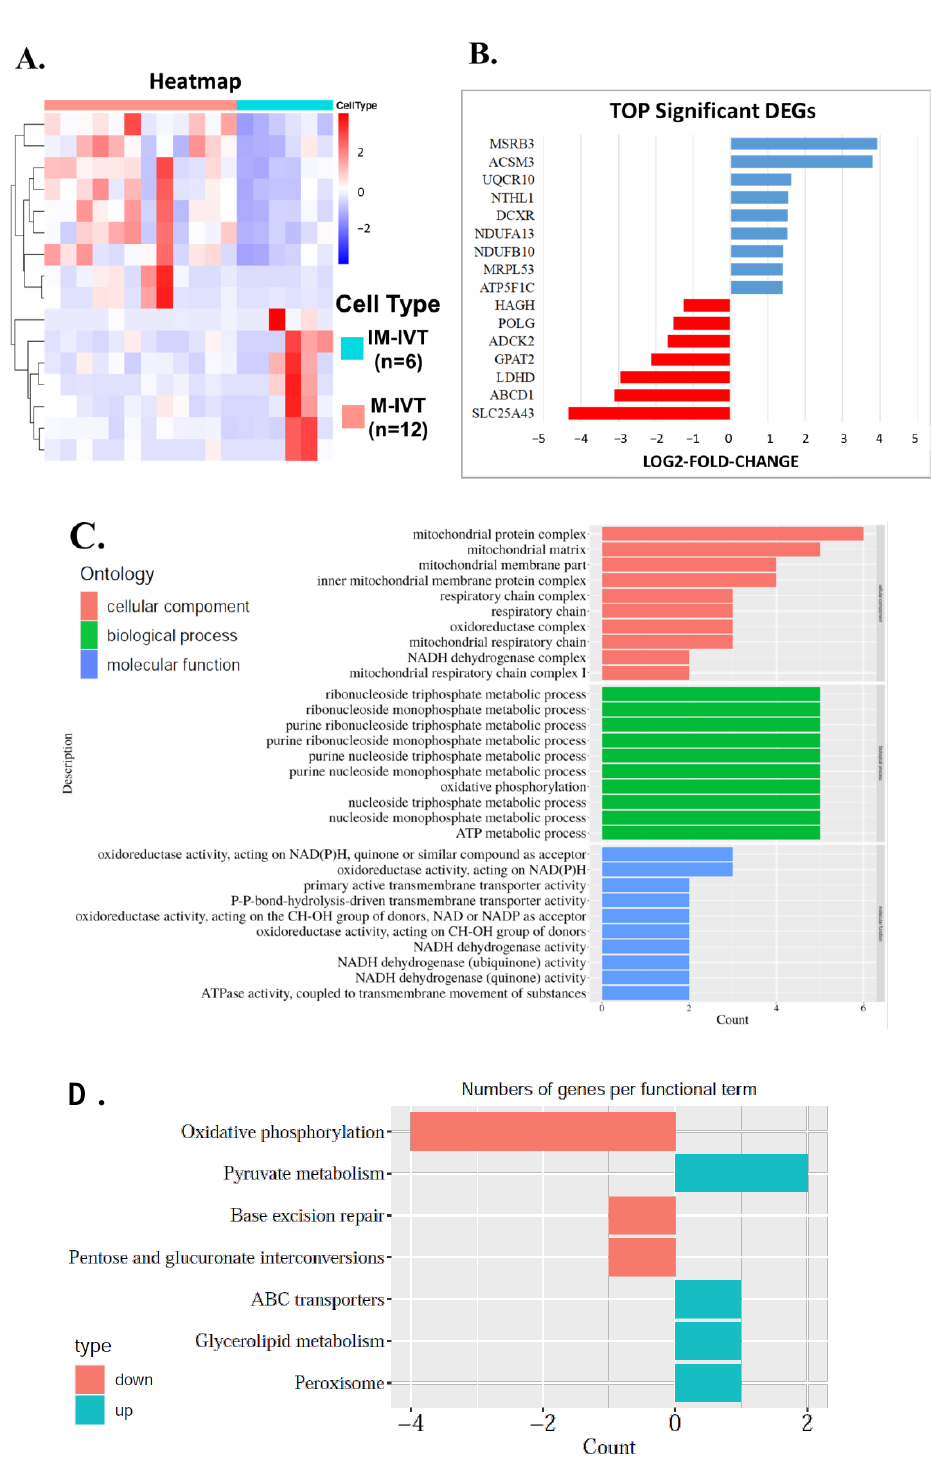
Figure 3. The alterations of mitochondria-related genes in the comparison between M-IVT group and IM-IVT group. ( A ) Hierarchical clustering of differentially expressed genes (DEGs) in oocytes between M-IVT and IM-IVT based on Z-score normalized FPKM values. Each column represents a sample, and each row represents a gene. Blue indicates lower expression and red indicates higher expression. ( B ) Top significant DEGs in oocytes between M-IVT and IM-IVT. ( C ) GO classification of DEGs in oocytes between M-IVT and IM-IVT. X -axis represents the GO terms. Y -axis represents the number of genes. ( D ) Kyoto Encyclopedia of Genes and Genome analysis of DEGs in oocytes between M-IVT and IM-IVT. X -axis represents the counts. Y -axis shows the name of the statistical pathway enrichment. Abbreviation: ABCD1, ATP binding cassette subfamily D member 1; ABC transporters: ATP-binding cassette (ABC) transporters; ACSM3, acyl-CoA synthetase medium chain family member 3; ADCK2, aarF domain containing kinase 2; ATP5F1C, ATP synthase F1 subunit gamma; DCXR, dicarbonyl and L-xylulose reductase; GPAT2, glycerol-3-phosphate acyltransferase